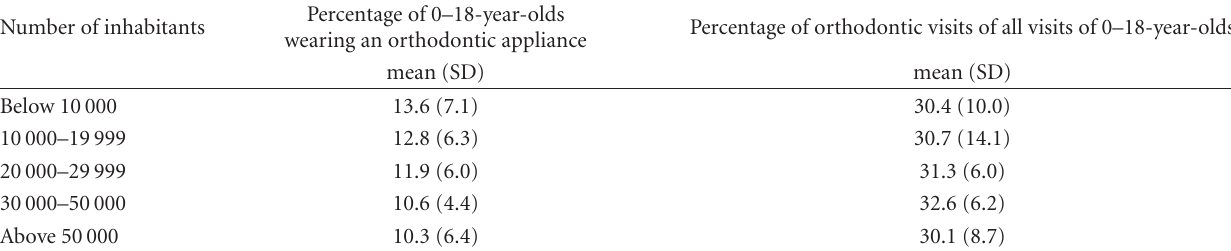
Table 1: The volume of orthodontic services in the health centres of di ff erent size groups in 2001 measured by the number of 0–18-year-old children wearing appliances and by the share of orthodontic visits of all visits in the age group of 0–18-year-olds.